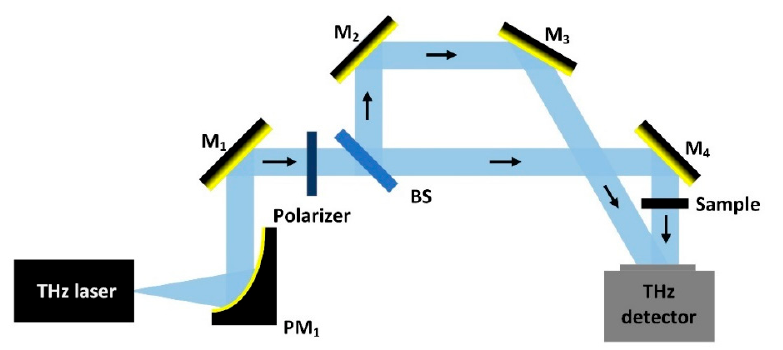
Figure 9. Schematic layout of the setup of off-axis CW